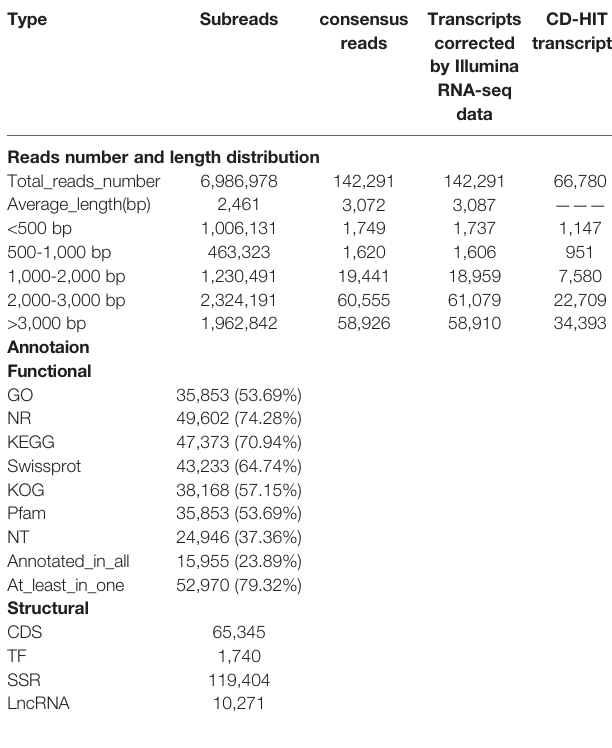
TABLE 1 | Reads and annotation statistics for the ISO-seq